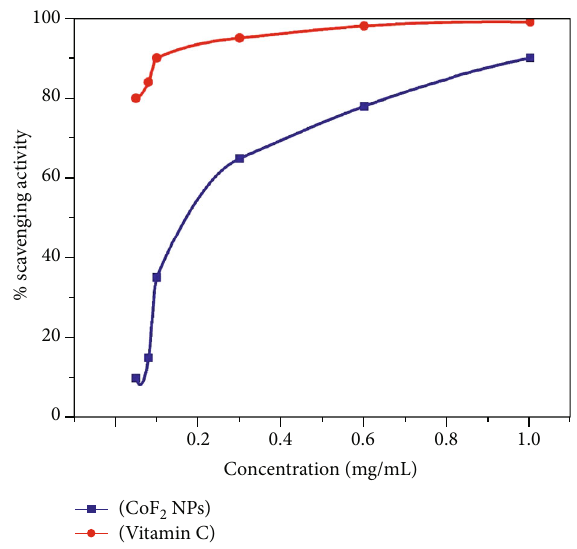
Figure 8: Percentage DPPH scavenging of CoF